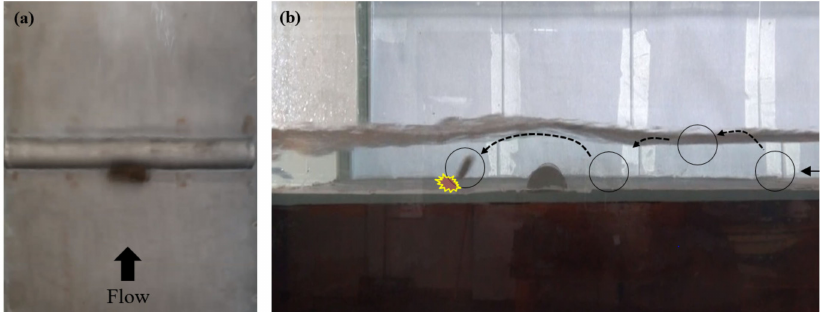
Figure 9. Analysis of bed-load collision state using video. ( a ) Success; ( b )